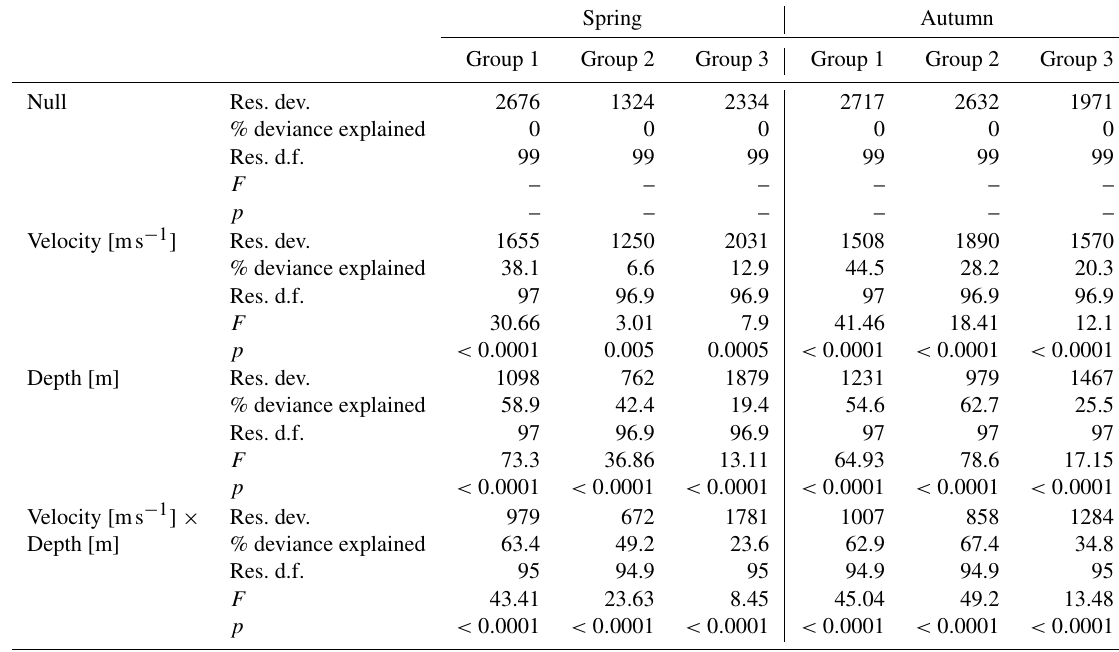
Table 3. Summary of the generalized additive models for BMWP_PL according to velocity and water depth parameters in the three river groups for spring and autumn season. Res. dev. – residual deviance, % deviance – percentage of total deviance, Res. d.f. – residual degrees of freedom, p – significance value.